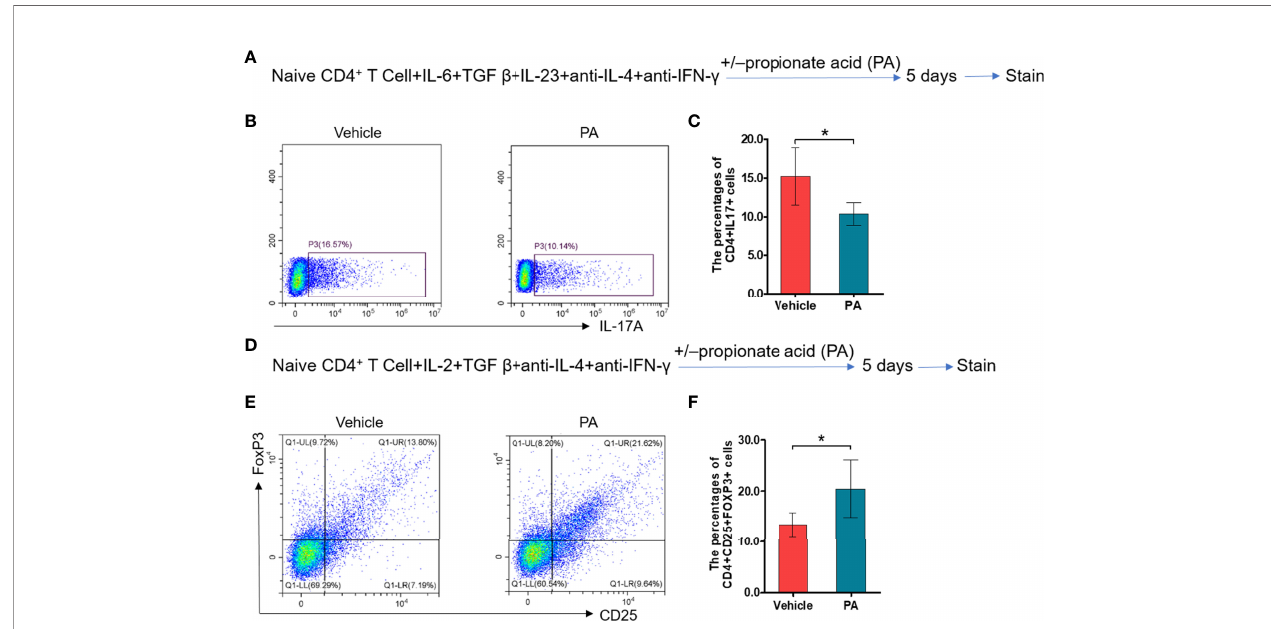
FIGURE 6 | Propionic acid regulates Th17/Treg cell differentiation in vitro. (A) Sorted naive CD4 + T cells were activated for 5 days under Th17 cell differentiation conditions with or without propionic acid and subjected to fl ow cytometry analysis for IL-17a. (B) Representative pictures of fl ow cytometric staining for CD4 + IL-17 + cells from the vehicle group (without propionic acid treatment) and the PA group (incubated with propionic acid). (C) Flow cytometric analysis of the CD4 + IL-17 + cells ’ proportion. (D) Sorted naive CD4 + T cells were activated for 5 days under Treg cell differentiation conditions with or without propionic acid and subjected to fl ow cytometric analysis for FoxP3. (E) Representative pictures of fl ow cytometric staining of CD4 + CD25 + FoxP3 + cells from the vehicle group and the PA group. (F) Flow cytometric analysis of the CD4 + CD25 + FoxP3 + cell proportion. Data are representative of three independent experiments. n = 5/group; * p < 0.05; PA, propionic acid; IL-17, interleukin-17; FoxP3, forkhead box P3; Treg, regulatory T